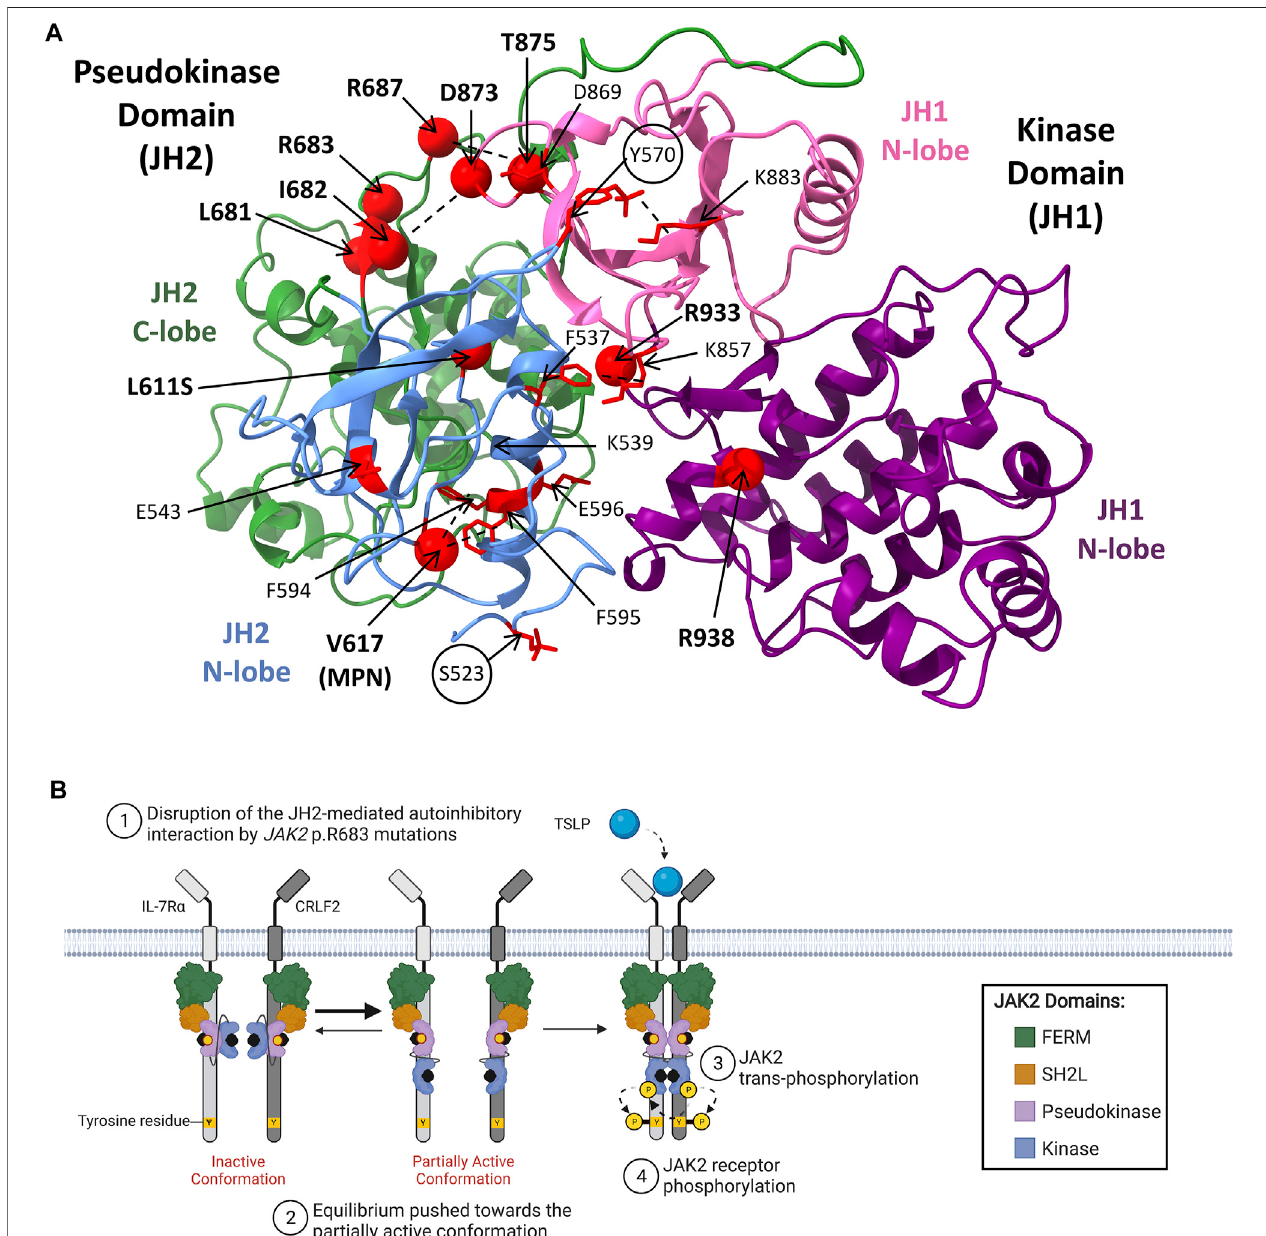
FIGURE 4 | JAK2mutations in hematological malignancies. (A) Model of JAK2 JH2-JH1 interface showing the positions of known activating JAK2 mutations. The JAK2JH2-JH1modelwasgeneratedbyShan etal. (2014)usingmoleculardynamicssimulationsandannotatedusingChimeraX-1.2.5(UniversityofCalifornia).TheJH2 (pseudokinase domain) N-terminal(residues536 – 629)and C-terminal(residues 630 – 839) lobearecoloredinlightblue and green respectively.The JH1(kinasedomain) N-terminal (residues 840 – 931) and C-terminal (932 – 1,132) lobes are colored in pink and purple respectively. Residues that when mutated are known to be activating are shown as red spheres ( α carbon). Two critical inhibitory phosphorylation sites, pS523 and pY570, are encircled. Other key residues predicted to be involved in activating JAK2 mechanisms are colored in red and presented with amino acid side chains shown. Proposed interactions are represented by dashed lines. Figure adapted from Shan et al. (2014), Hammarén et al. (2019a), Leroy et al. (2016) and Lupardus et al. (2014). (B) Schematic representation of JAK/STAT signaling pathway activation through mutant-JAK2. CRLF2 (dark grey) heterodimerizes withIL-7R α (light grey)to form the cytokine receptor for TSLP. The JAK2 FERM and SH2- likedomainsassociatewiththecytoplasmicjuxtamembranemotifsofthereceptortorecruitJAK2tothecellmembrane.ThefourdomainsofJAK2arepresented:FERM (green), SH2-like (orange), pseudokinase (JH2, purple), and kinase (JH1, blue). JAK2 is shown bound to ATP (black). The proposed model of mutant-JAK2 activation suggeststhatmutationssuchas JAK2 p.R683G(representedbyayellowsphere)disrupttheJH2-mediatedautoinhibitoryinteractionwiththekinasedomain.Thisshifts the equilibrium of JAK2 from the inactive, auto-inhibited state towards the partially active state, supporting mutant-JAK2 dimerisation. Although mutant-JAK2 alone remains dependent on cytokine binding, additional mechanisms such as receptor overexpression may promote malignant transformation. Adapted from “ Cytokine Signaling through the JAK-STAT Pathway ” (BioRender.com, 2021).